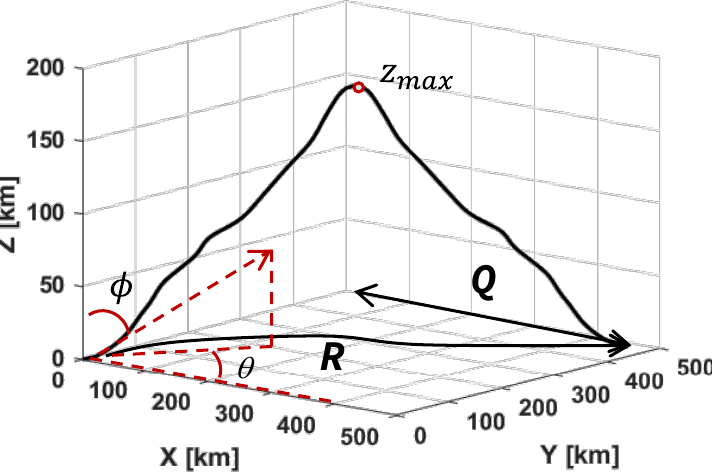
Figure 1. Propagation trajectory of the tau-p model in a phase loop, the azimuth angle θ , the angle of elevation φ , the altitude of infrasound propagation z , the infrasound propagation distance R of a phase loop in Equation (2), the maximum altitude z max that a phase loop can propagate, and the transverse offset Q of infrasound propagation in Equation (4) (the red arrow and red dot indicate the direction of infrasound propagation at the starting point and the location of the maximum elevation of infrasound propagation,